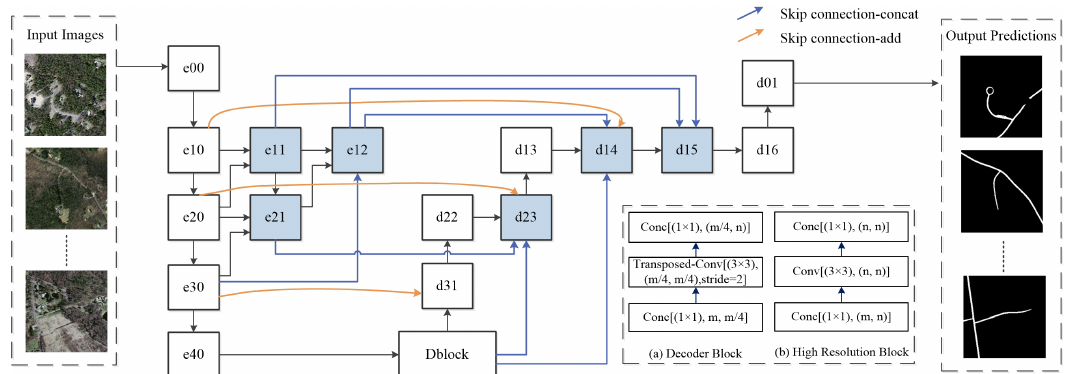
Figure 4. Dense encoder–decoder teacher network (D-EDTN). The left images are the inputs of the network, and the right images are the outputs. The eij indexes the encoder block and dij indexes the decoder block. Here, i indexes the same size of the feature layer, and j indexes the net’s convolution layer. Dblock is the center dilation part in D-LinkNet [11]. The skip orange lines are the addition operation, and the skip blue line is the concatenation operation. The two blocks in the lower right corner are the ( a ) Decoder Block: the encoder block in the teacher net, and the ( b ) High-Resolution Blocks (HRBs): the blue blocks in the teacher net.